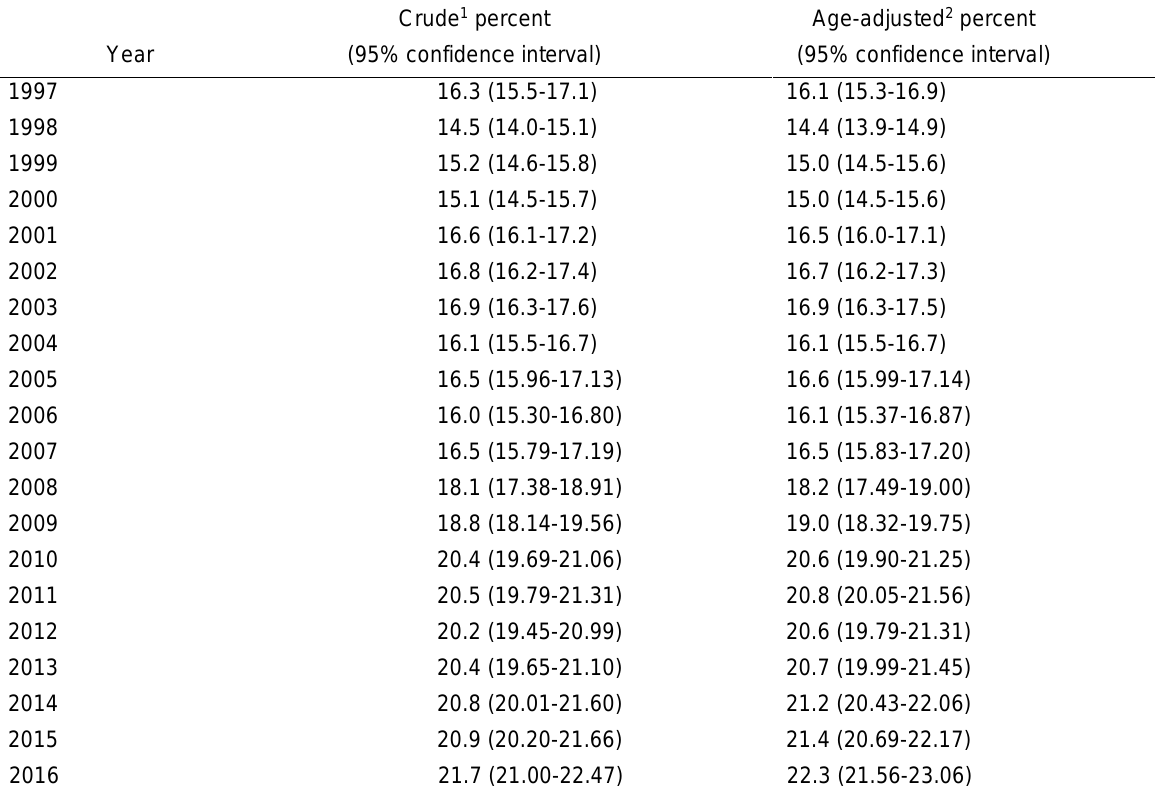
Data table for Figure 7.4. Percentage of adults aged 18 and over who met